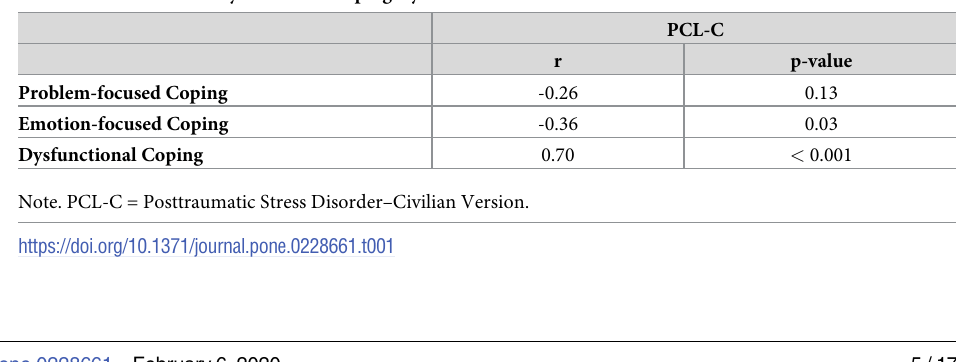
Table 1. Correlation analysis between coping style clusters and PCL-C scores.